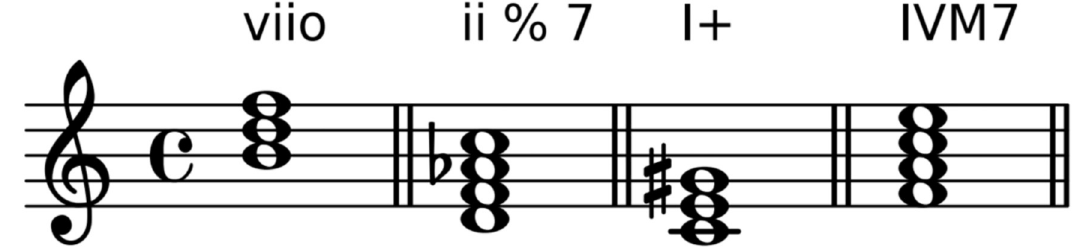
Fig 1. Chord forms. Examples of diminished, half-diminished, augmented, and major seventh chords with notation according to the ABC standard.